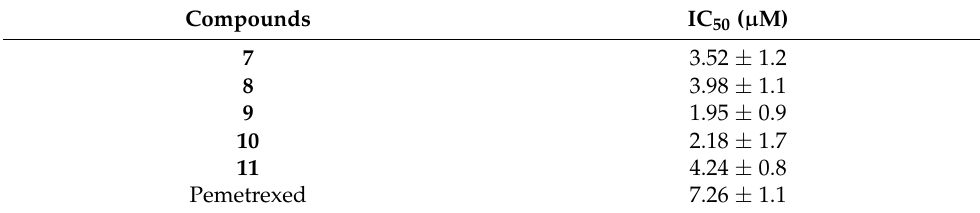
Table 3. Thymidylate synthase (TS) activity of the potent